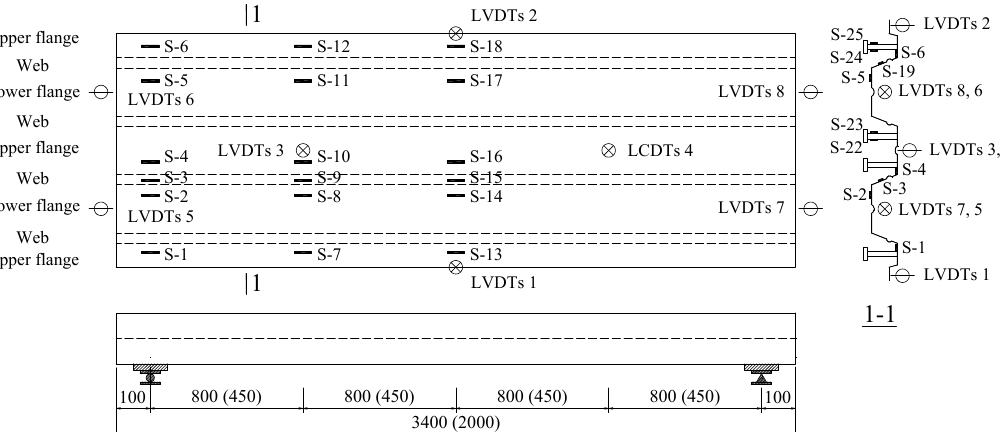
Figure 6. Location of linear variable displacement transducers (LVDTs) and strain gauges of profiled steel sheeting (all dimensions are in mm).